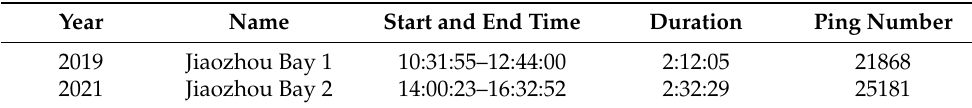
Figure 5. AUV trajectories and the manually labeled sand wave region. ( a ) AUV trajectories. ( b ) The manually labeled sand wave region.